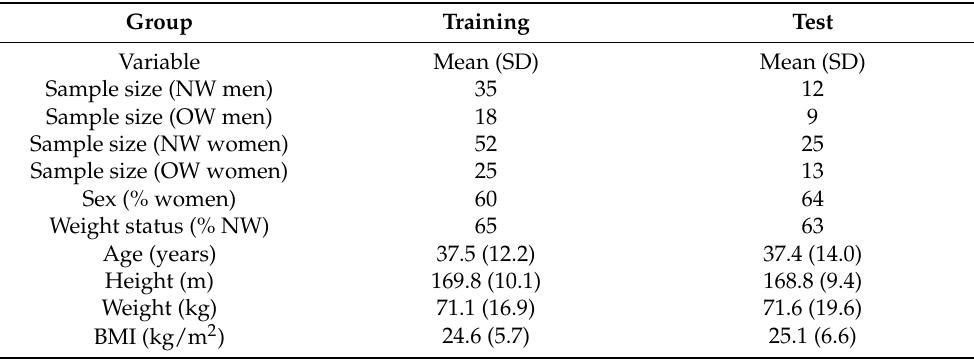
Table 1. Characteristics of both training and test groups. (Mean values and standard